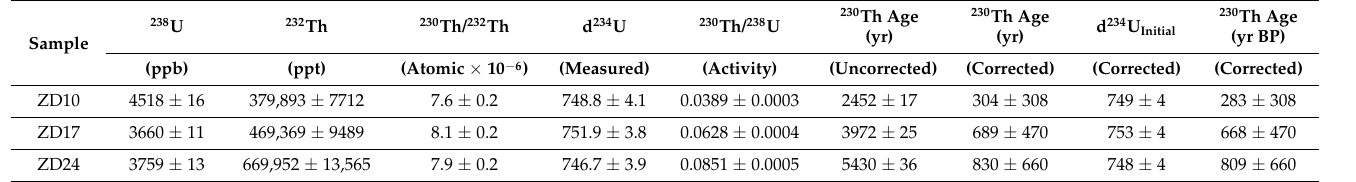
Table 1. 230 Th dating results for profiles in study area ( ± 2 σ